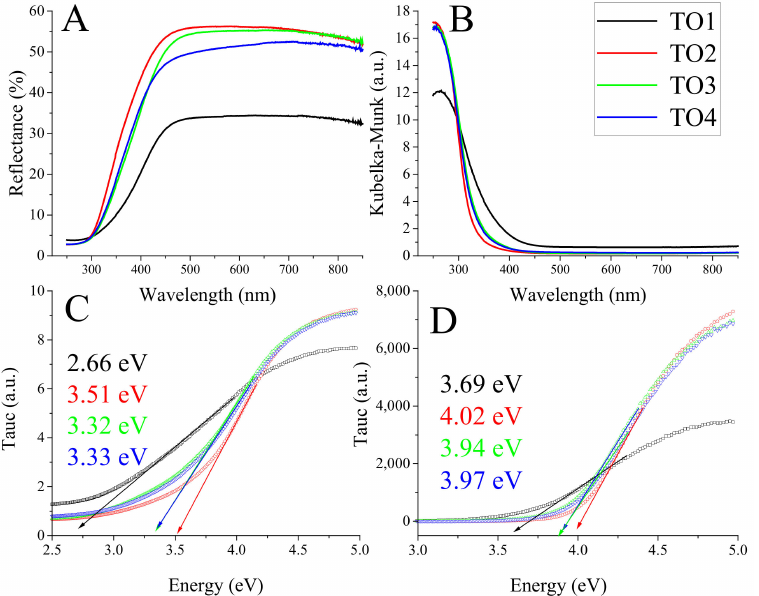
Figure 5. UV–Vis DRS data: DRS spectra ( A ); absorption spectra obtained by Kubelka–Munk convert- ing ( B ); Tauc plot calculated for indirect transition ( C ); Tauc plot calculated for direct transition ( D ). E g values for indirect and direct transitions were 2.66 and 3.69 eV for TO1, 3.51 and 4.02 eV for TO2, 3.32 and 3.94 eV for TO3, and 3.33 and 3.97 eV for TO4. The values obtained band gap (samples TO1 and TO2). Ageing during synthesis (sample TO3) decreased